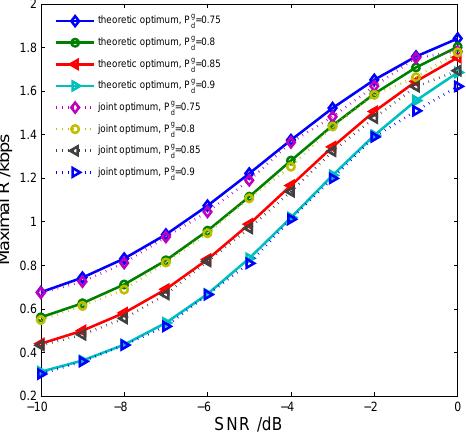
Figure 8. Maximal throughput versus theoretic optimum and joint